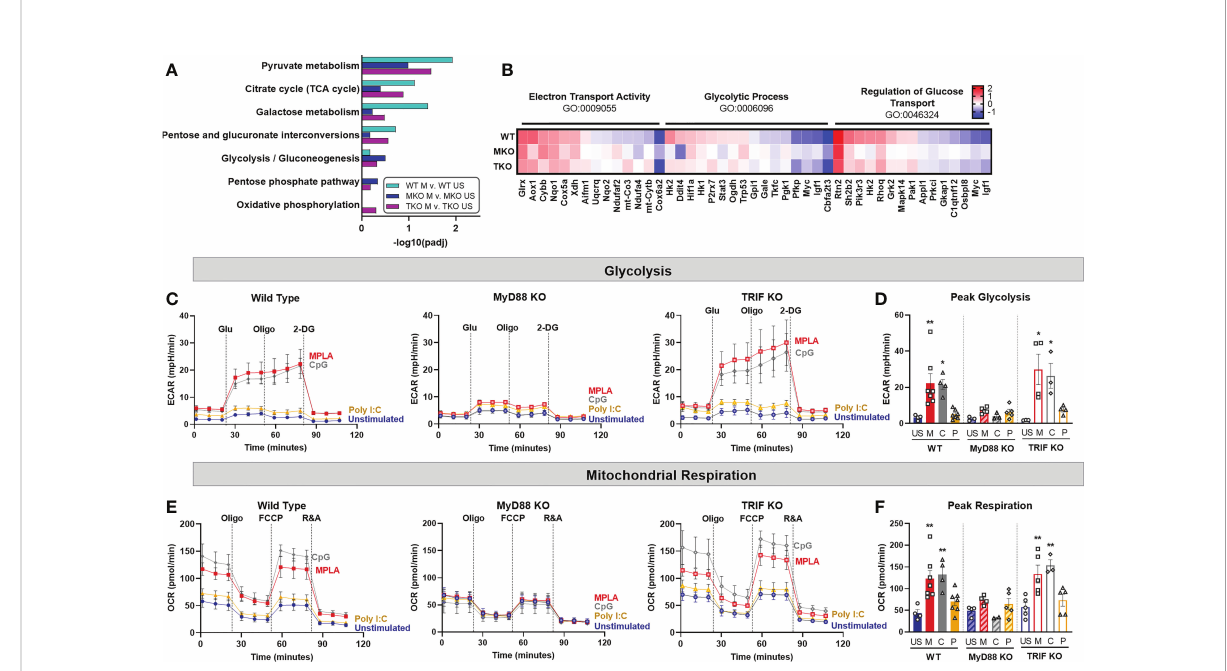
FIGURE 5 TLR-induced metabolic rewiring is lost in MyD88-de fi cient macrophages. (A, B) Gene Ontology (GO) functional enrichment analysis was conducted on MPLA-treated WT, MyD88-KO (MKO), and TRIF-KO (TKO) bone marrow-derived macrophages (BMDMs) for metabolism-related pathways and displayed by signi fi cance of pathway induction (A) . Differential expression of genes in metabolism-related GO pathways are shown by heatmap (B) . (C, D) Glycolysis stress test was performed using Seahorse Xfe96 which measured extracellular acidi fi cation rate (ECAR) of TLR agonist-treated (MPLA, M; CpG, C; Poly I:C, P) or unstimulated (US) WT (left) MKO (middle), and TKO (right) BMDMs (C) . Peak glycolysis was measured (D) . (E, F) Mitochondrial stress test was performed under the same experimental parameters and oxygen consumption rate (OCR) is presented for WT (left), MKO (middle), and TKO (right) BMDMs (E) . Peak respiration was measured (F) . Data are shown as mean ± SEM, n = 3- 5/group *p < 0.05, **p < 0.01 by ANOVA followed by Dunnett ’ s post-hoc multiple comparison